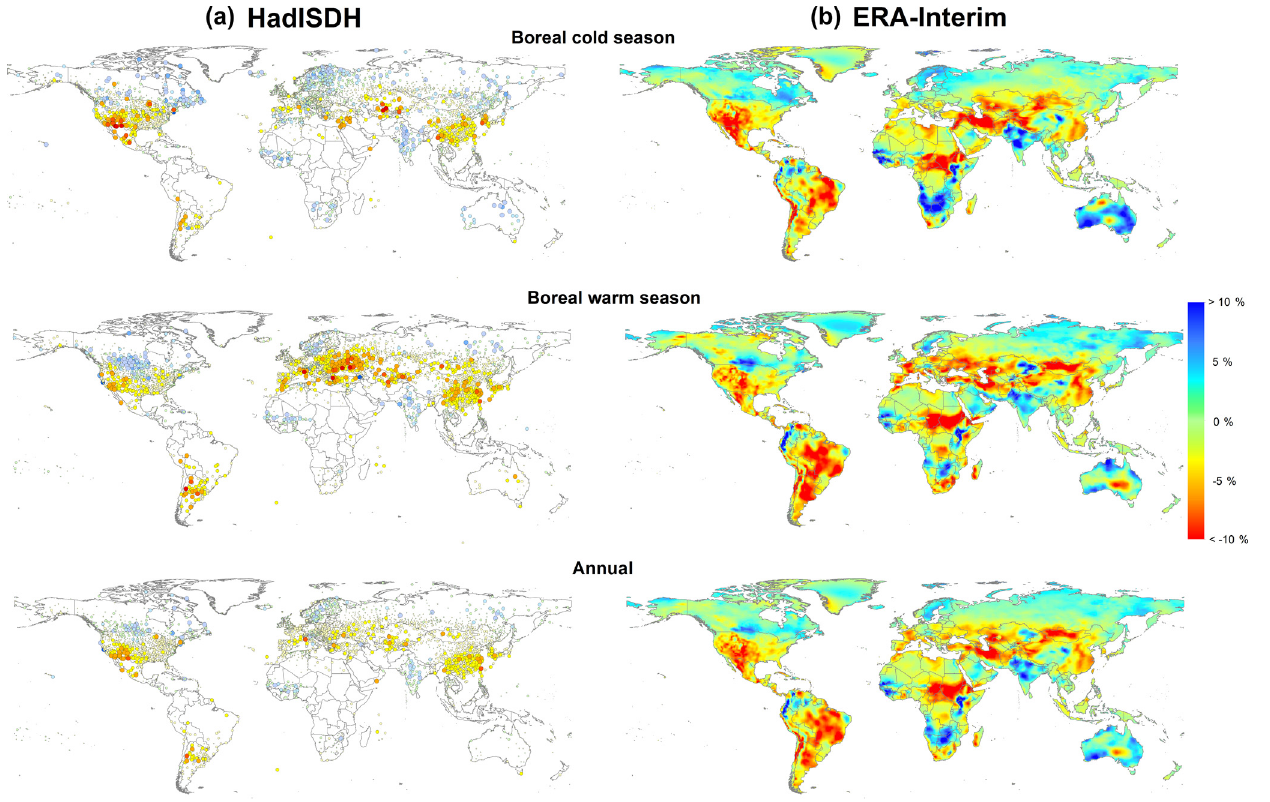
Figure 1. Spatial distribution of the magnitude of change of RH (% per decade) over the period 1979–2014 from the HadISDH (a) and ERA-Interim datasets (b) . Results are provided for the boreal cold (October–March) and warm (April–September) seasons and